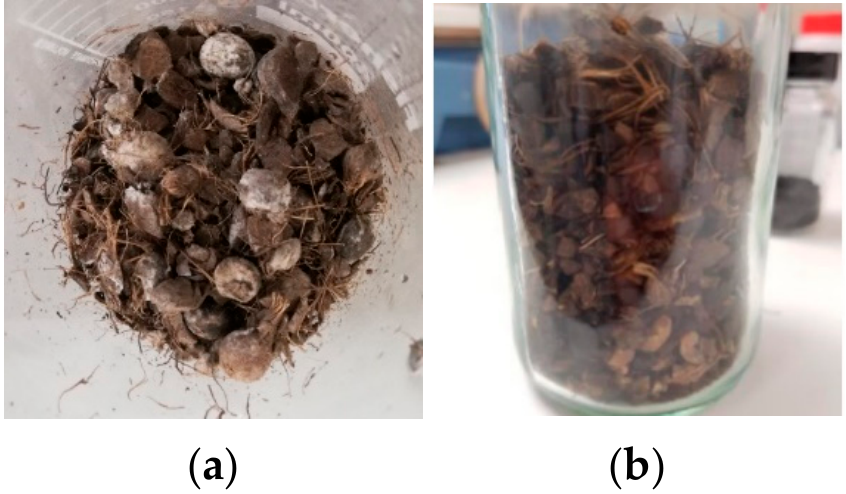
Figure 1. Palm oil residues, POR, as received ( a ) and after pre-treatment ( b ).